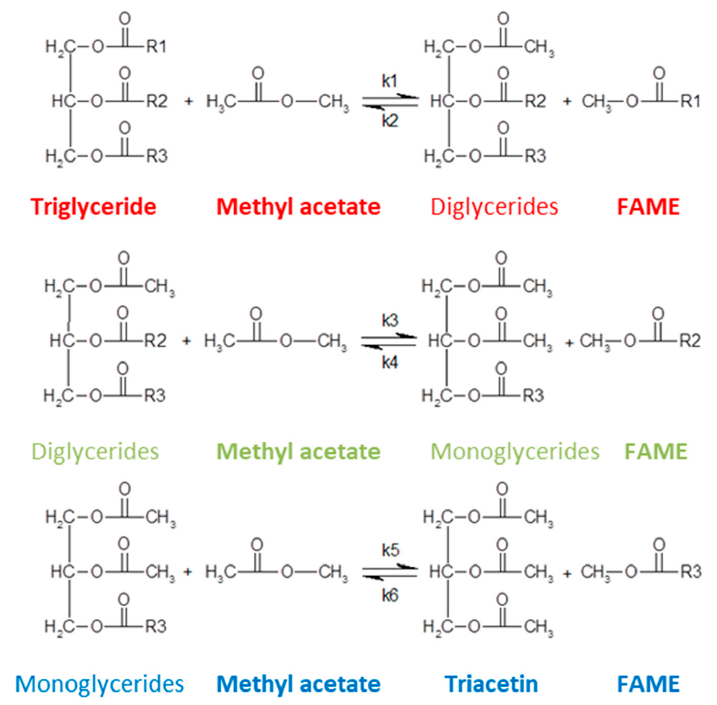
Figure 1. Simplified reaction network or scheme for the interesterification process of methyl acetate and triglycerides from castor oil: triglycerides are transformed into 1,2 and 1,3 diglycerides (grouped as diglycerides) and FAMEs; diglycerides are the source of 1- and 2-monoglycerides and FAMEs. These, in turn, react with more methyl acetate to obtain triacetin and more FAMEs. All these consecutive reactions are interesterifications catalyzed by Lipozyme ® TL IM.